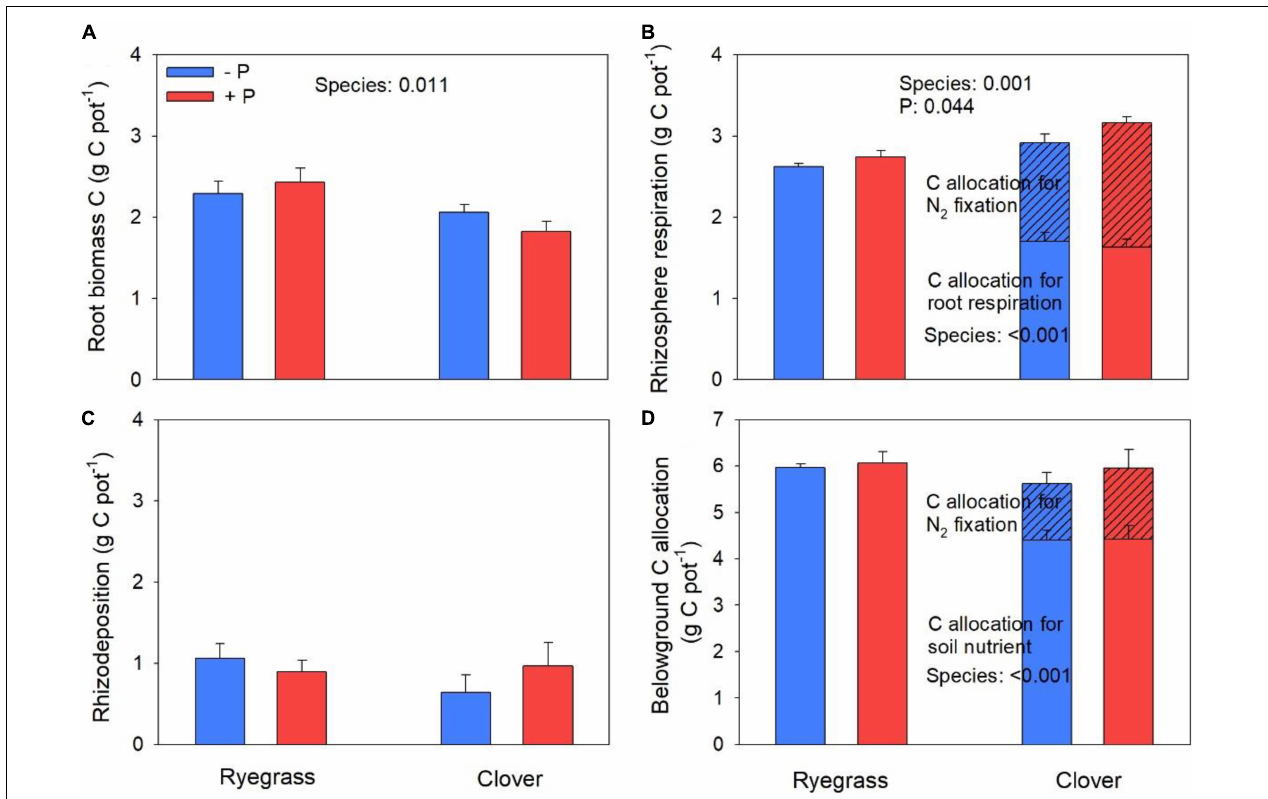
FIGURE 1 | Root biomass C (A) , rhizosphere respiration (B) , rhizodeposition (C) , and total belowground C allocation (D) of ryegrass and clover with and without P addition. For rhizosphere respiration and total belowground C allocation, allocation was separated into C allocation for biological N fixation (shaded bars) and for nutrient uptake from the soil (non-shaded bars). Sub-legend shows ANOVA p -values. Error bar indicates one standard error of the mean ( n =